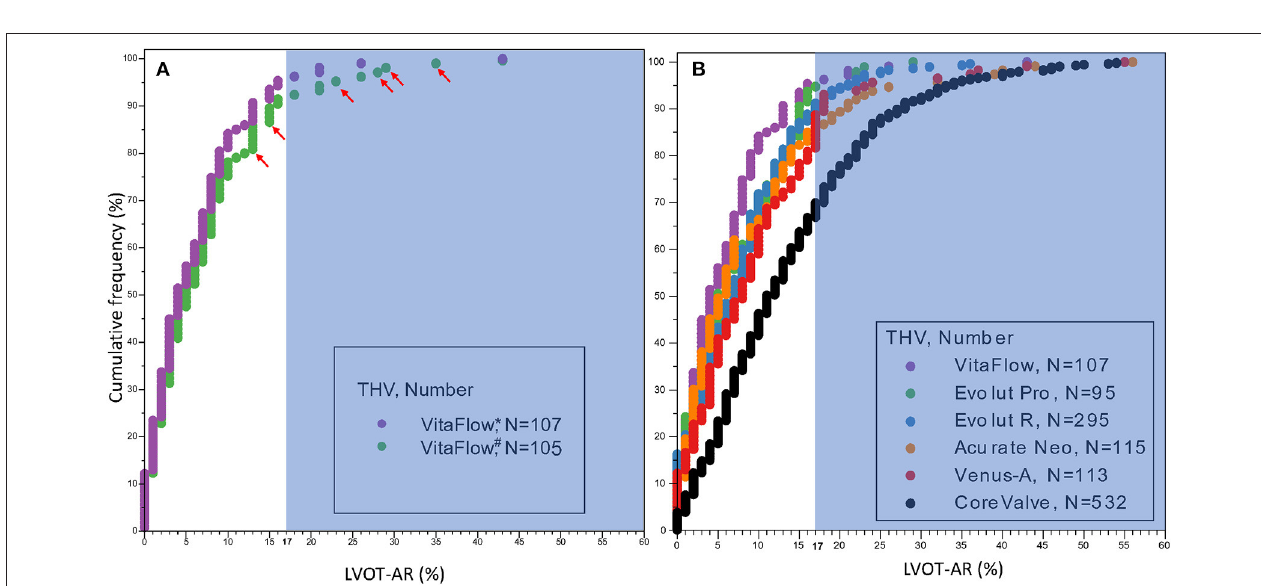
FIGURE 4 | Cumulative frequency curves of LVOT-AR after TAVR for VitaFlow (A) and the six THVs (B) . The shaded background shows the area above 17% of AR, indicating moderate or severe regurgitation. LVOT-AR, quantitative aortic regurgitation in the left ventricular outflow tract; TAVR, transcatheter aortic valve replacement; THV, transcatheter heart valve. VitaFlow*: the analysis of LVOT-AR using the final aortogram (after the second valve implantation), VitaFlow # : the analysis of LVOT-AR using the intermediate aortograms. The red arrows show the LVOT-AR in the six valve-in-valve cases using the intermediate